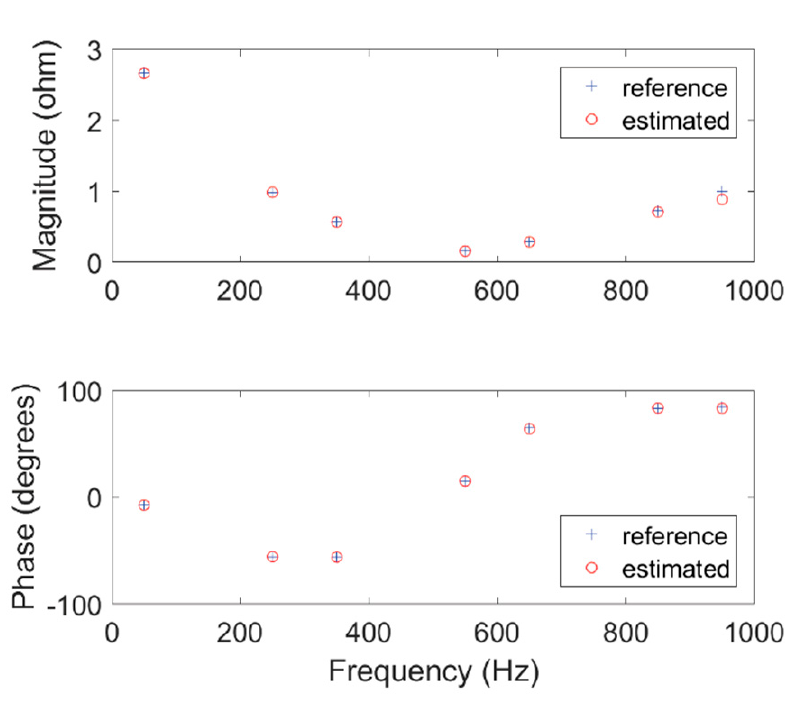
Figure 4. The reference and the estimated impedance of the modeled distribution grid seen from the secondary side of the HV-MV transformer.